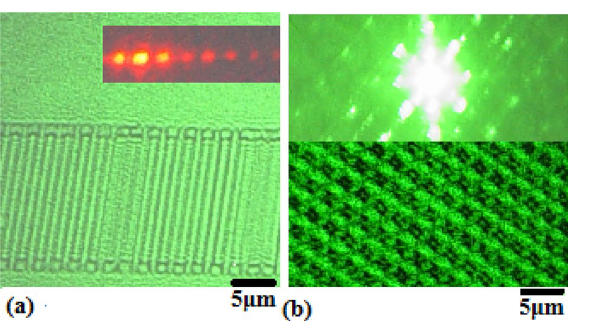
Figure 2. LRTM images on 1D ( a ) and 2D ( b ) photonic crystals of silicon under laser illumination, in which the inset windows show the space frequency images (diffraction patterns) of 1D and 2D photonic crystal structures.